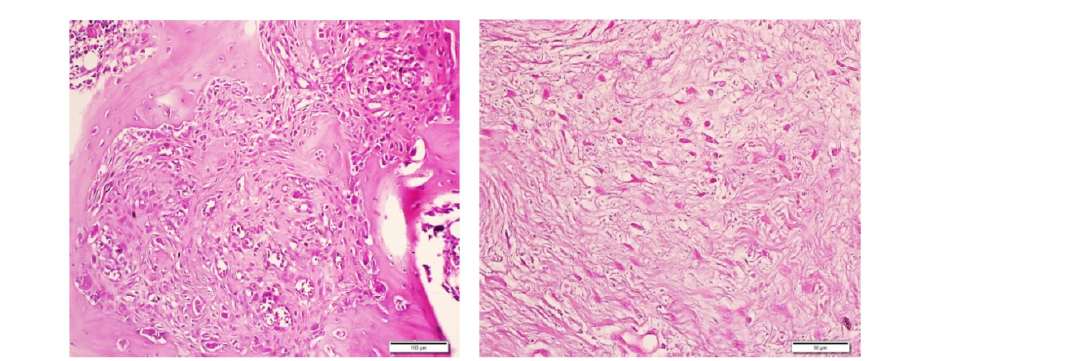
Figure 3: a: Healing signs in the foci of chronic osteomyelitis. b: Apparent neovascularization showing lumen formation in these foci. H&E,